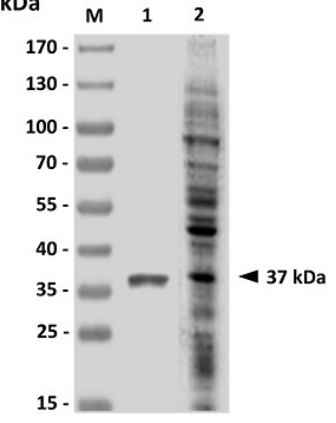
Figure 1. Analysis of purified recombinant GAPDH (rGAPDH) by western blotting. Purified E. coli -based rGAPDH protein (Lane 1) was analyzed with V. harveyi -infected grouper sera, which could recognize V. harveyi lysate (Lane 2). Standard protein markers (Lane M) are shown on the